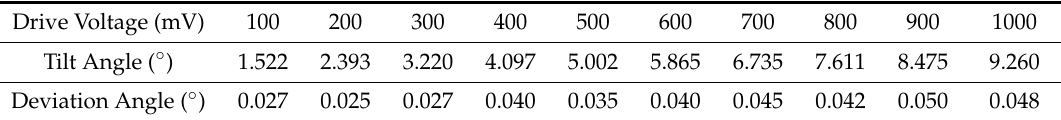
Table 1. Measured tilt angle and deviation angle versus applied drive voltage.